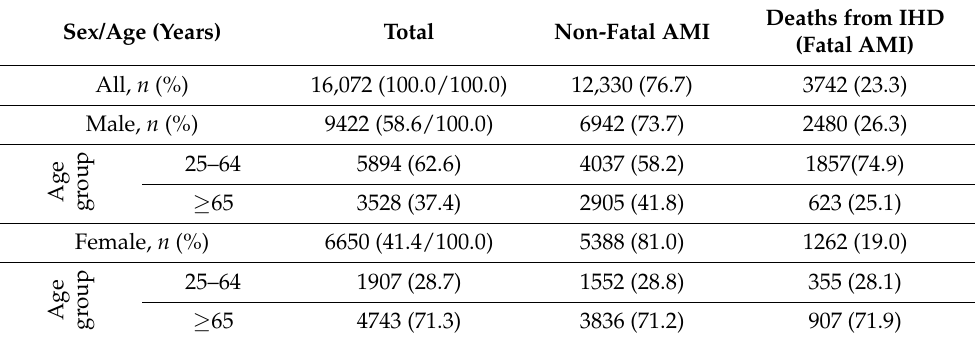
Table 1. Distribution of events of acute myocardial infarction (AMI) and deaths from ischemic heart disease (IHD) by sex and